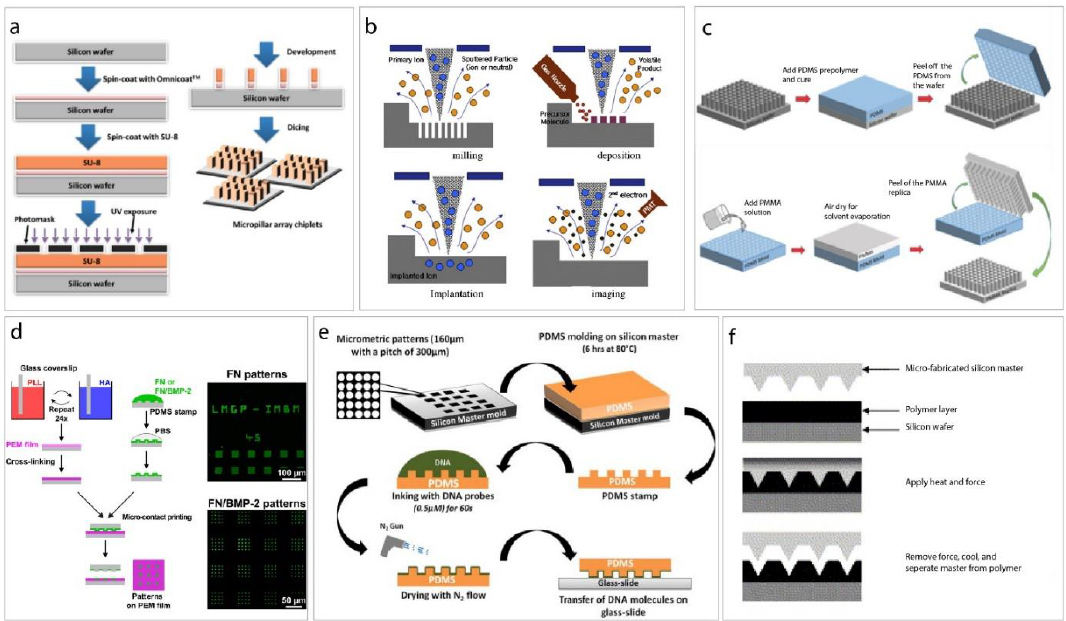
Figure 2. Schematic illustrations of micro- and nano-fabrication methods. ( a ) production of micro-scale surface topographies using photolithography. ( b ) electron beam lithography. ( c ) solvent casting (i.e., soft lithography). ( d ) micro-contact printing. ( e ) direct microcontact printing. ( f ) hot